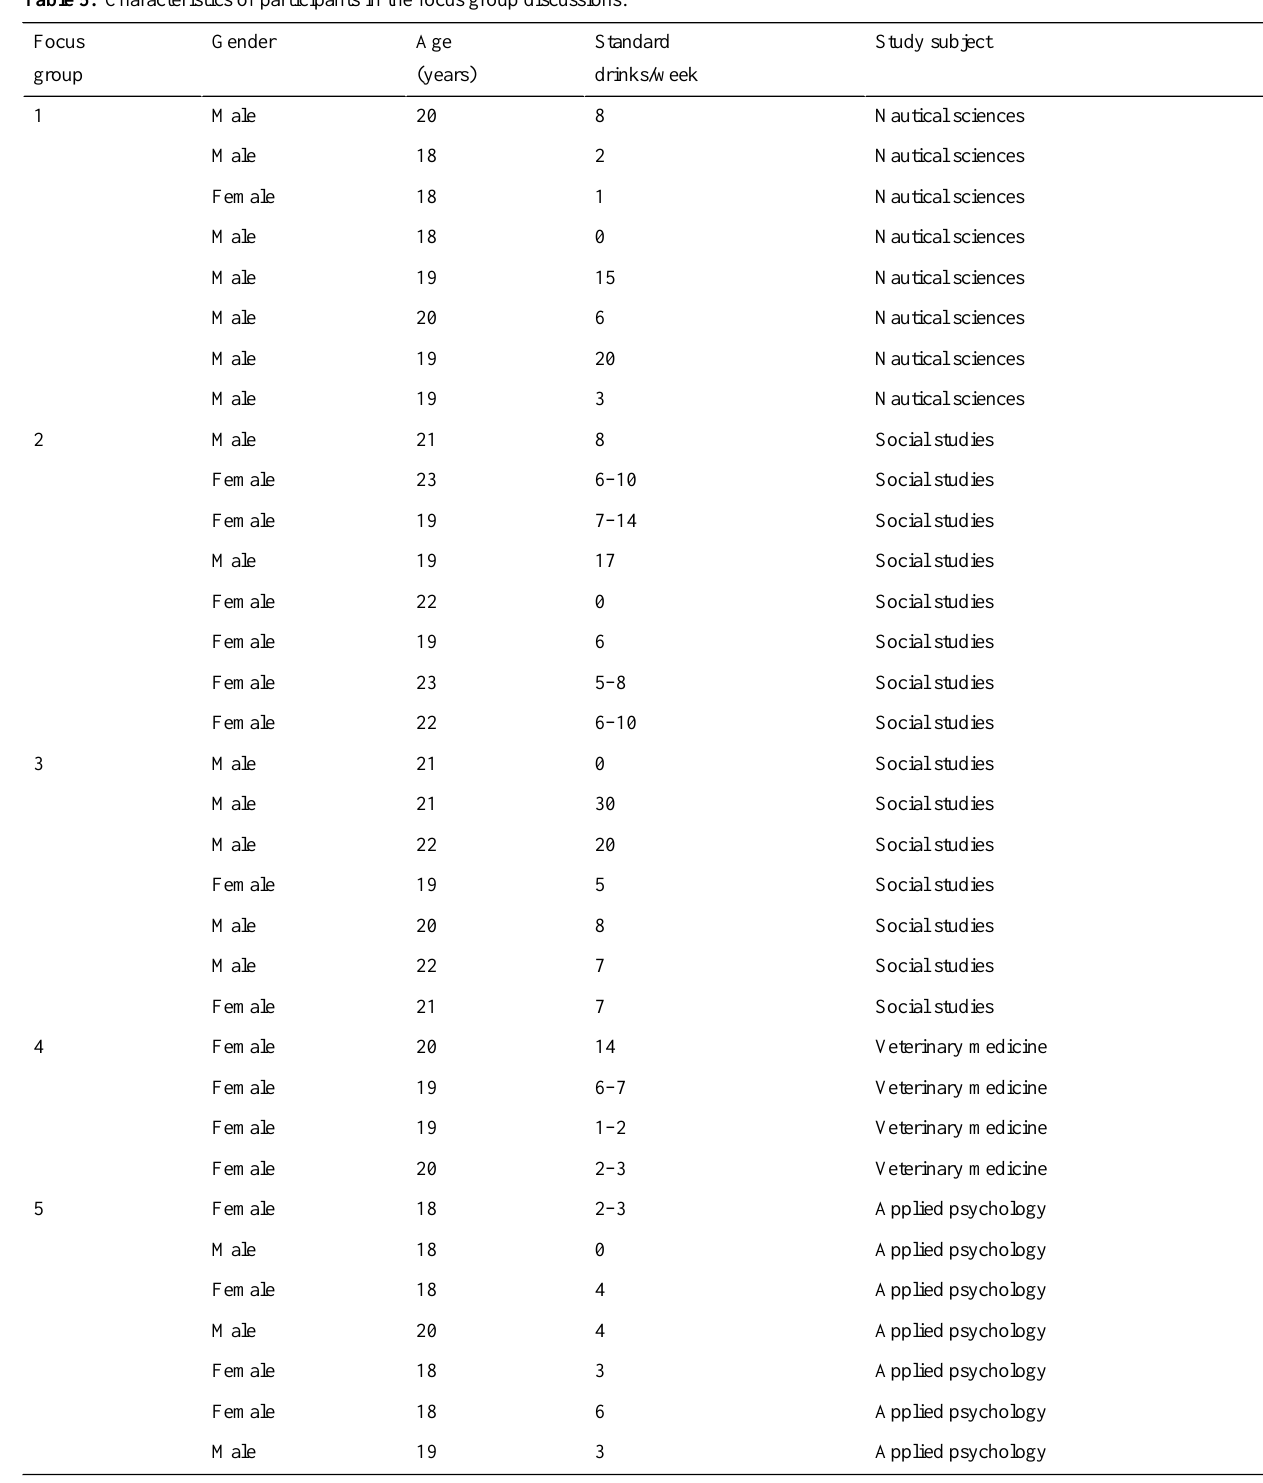
Table 5. Characteristics of participants in the focus group